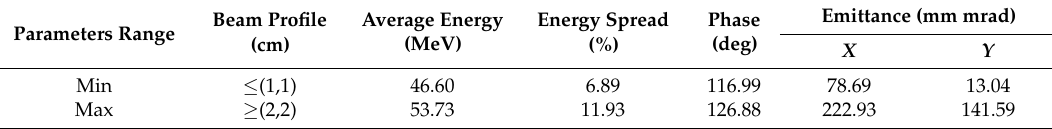
Table 1. Comparison of the beam parameters obtained at both maximum and minimum at the A0